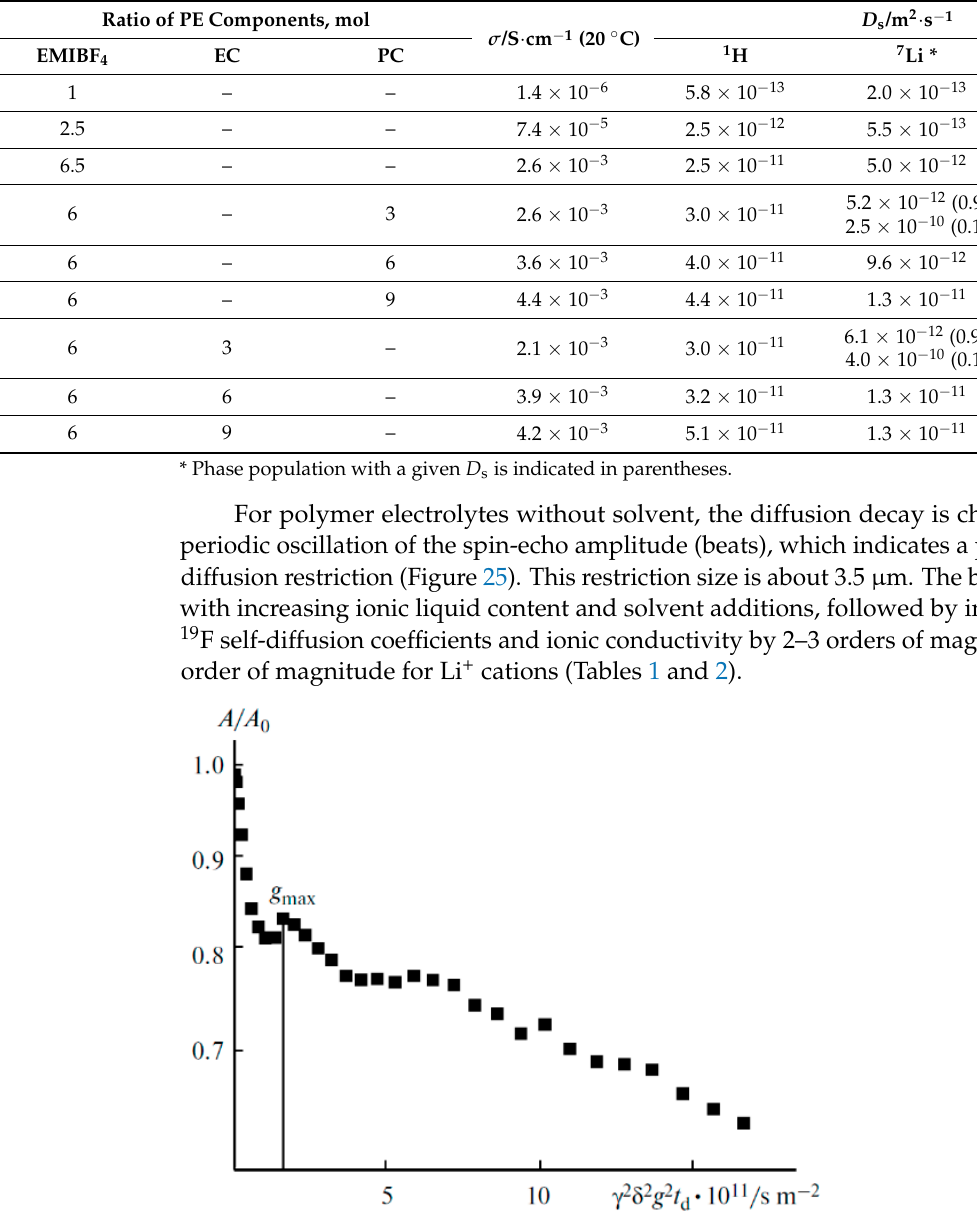
Figure 26. Diffusion decay on 7 Li for the composition of PE 5 [60]. Self-diffusion coefficients of 7 Li + cations in the cross-linked polymer gel electrolytes based on PEG DA-EMIBF 4 -LiBF 4 and the sample compositions are given in Table 8 [61]. As shown in Table 8, a small amount of solvent addition (EC and PC) results in phase (10% population) formation with high lithium cation self-diffusion coefficients D s 2 ( D s 2 = 4.0 × 10 –10 m 2 /s for sample 7 with EC and 2.5 × 10 –10 m 2 /s for sample 4 with PC, respectively), which are two orders of magnitude higher than the self-diffusion coefficients D s1 of the main population phases. It may be assumed that the fast Li + diffusion is due to the solva- tion of EC and PC complexes. At a higher solvent content, we observe the average self- diffusion coefficient as a result of a fast exchange between 7 Li located in different environ- ments, which increases with an increasing solvent amount (Table 8). Lithium and 1-ethyl-3-methylimidazolium tetrafluoroborates (EMIBF 4 ]) in PC solu- tions were studied by high-resolution 1 H, 7 Li, 11 B, 13 C, and 19 F NMR. The degree of solva- tion of Li + ions was also determined from a pulsed-field gradient 1 H, 7 Li, and 19 F NMR measurements. The structures of Li + solvation complexes with molecules of propylene car- bonate and BF 4 − anions and complexes associated with the ionic liquid were calculated using the density-functional theory. The calculated and experimental chemical shifts were compared. The structures of the complexes are shown in Figures 27 and 28.